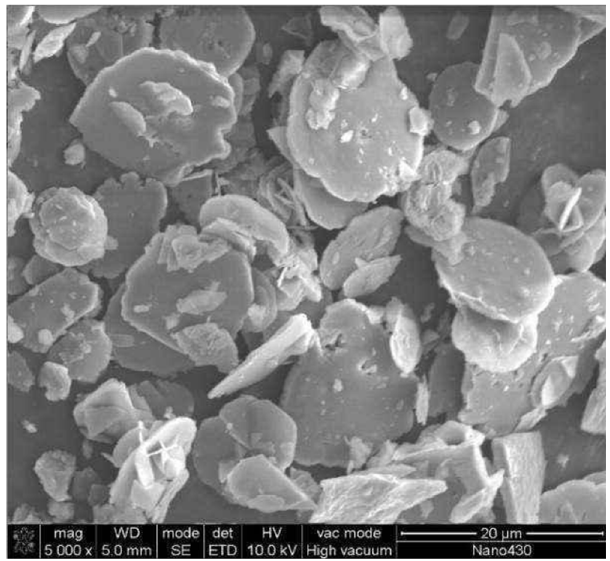
Fig. 19. The microstructure of urea crystals.